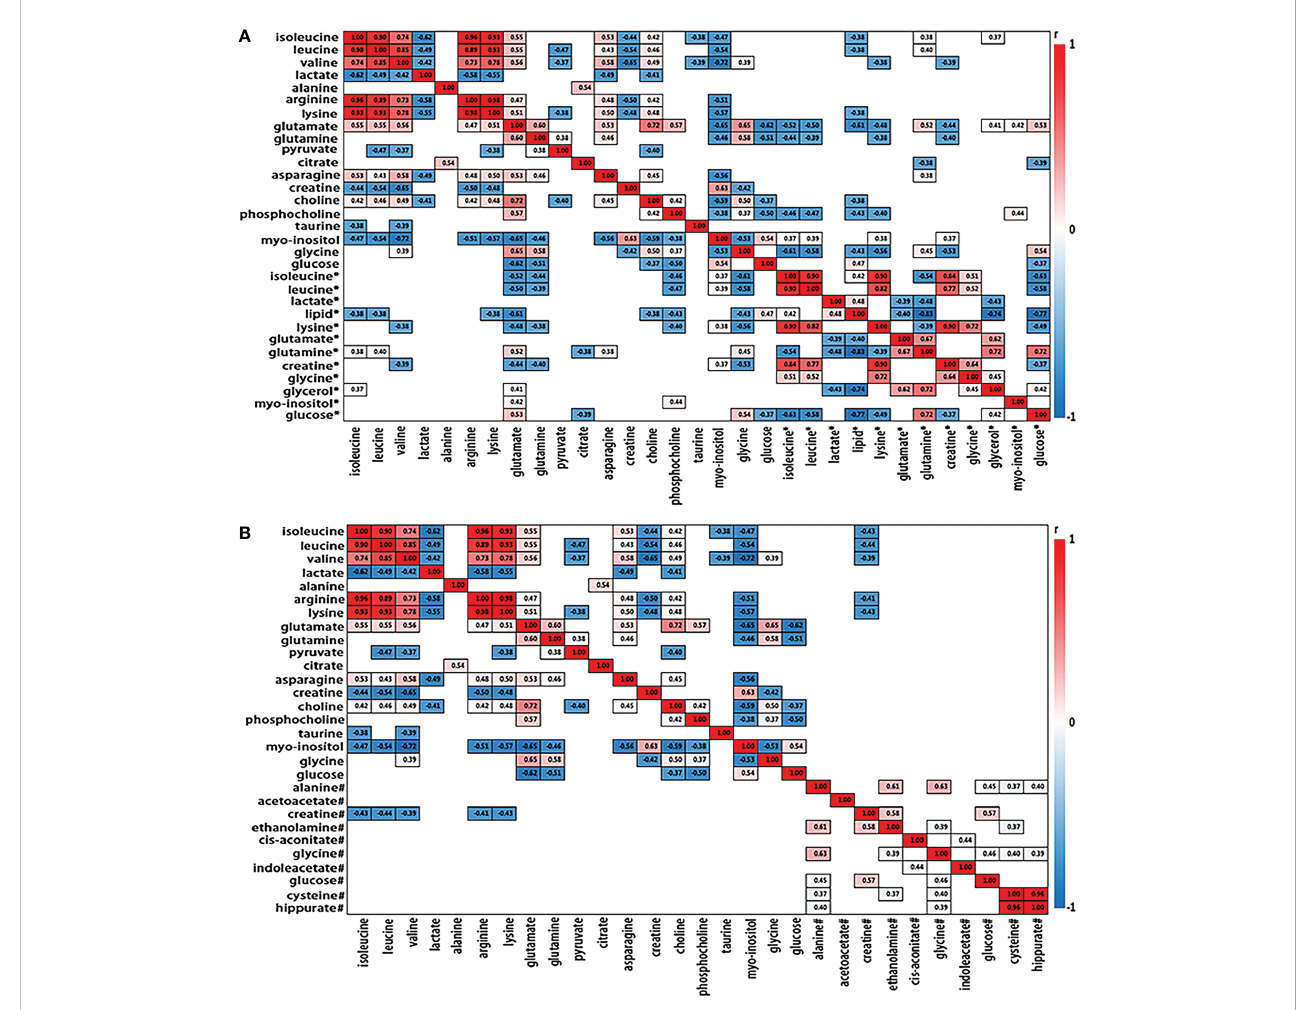
FIGURE 3 Heat map color-coded based on the strength of spearman correlation coef fi cients of metabolites identi fi ed as important in tumor vs serum discrimination (A) and urine discrimination (B) in test group. The cutoff values of |r| > 0.28 and p < 0.05 have been used (n=50). The metabolites used are given in Table 1. Red boxes indicated positive associations and blue boxes indicated negative associations. Metabolites without label noted tissue biomarkers; metabolites labeled with “ * ” and “ # ” noted serum and urine biomarkers,